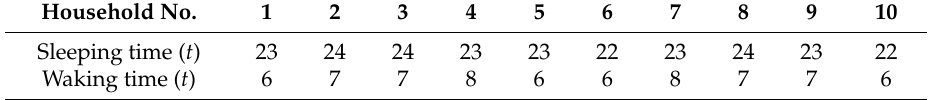
Table 4. Temperature control of each household in building.